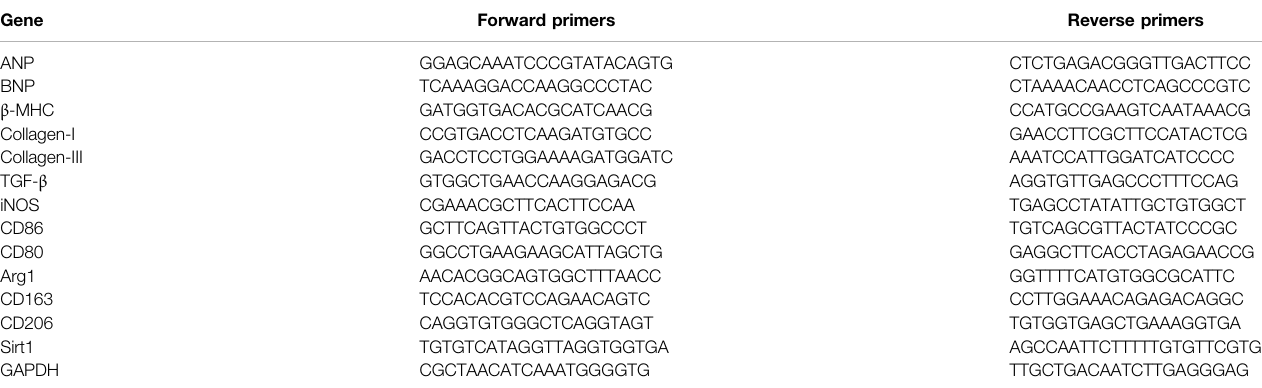
TABLE 1 | Mouse primers for